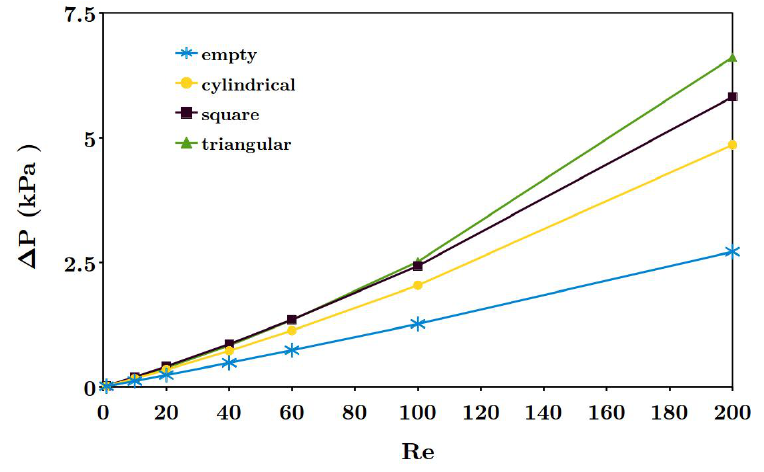
Figure 13. Comparison of pressure difference between inlet and outlet of the channel as a function of Re number for all studied geometries at T = 20 ◦